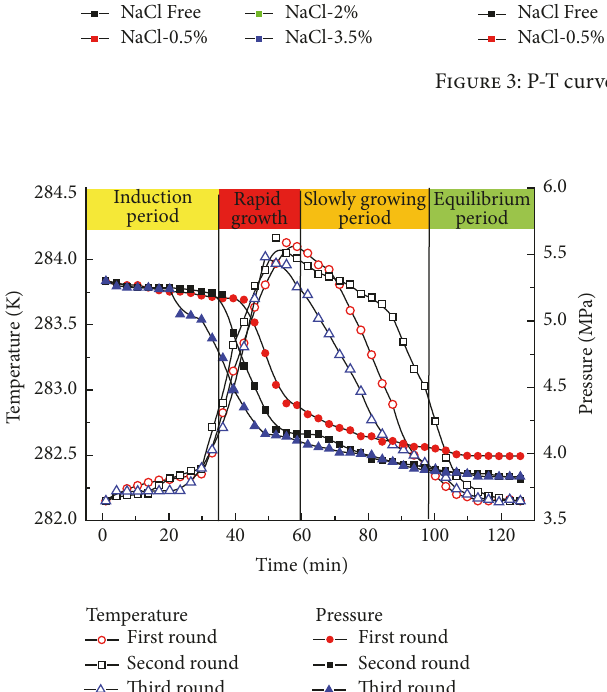
Figure 4: The curves of mine gas hydrate formation temperature and